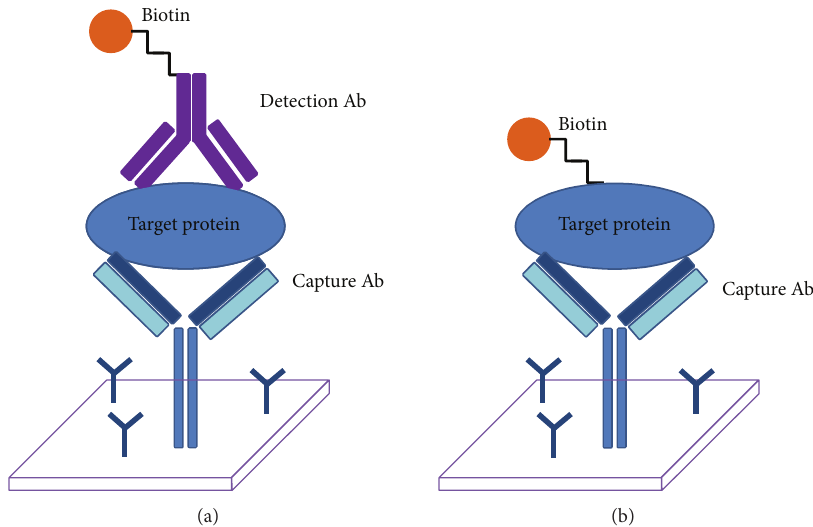
Figure 1: The principle employed in most antibody arrays. (a) The sandwich method which requires an immobilized capture antibody and a labeled detection antibody. (b) Direct-label method with capture antibody and labeled